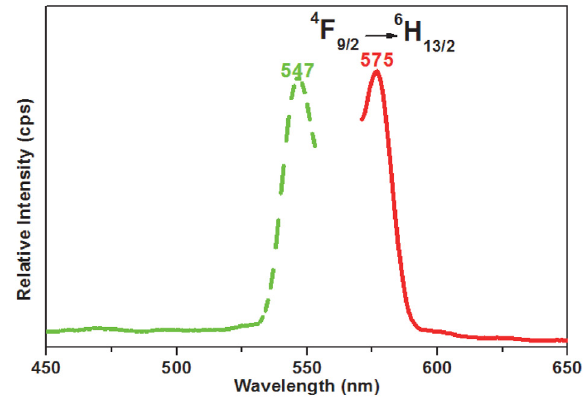
Figure 4. The solid state photoluminescence spectra of 1 measured at room temperature. Green dashed lines represent excitation and red solid lines represent emission.